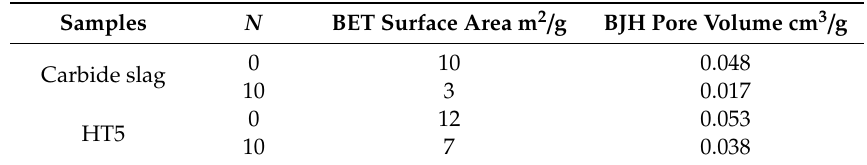
Table 4. Surface areas and pore volumes of HT5 and carbide slag (carbonation in 15% CO 2 / N 2 at 700 ◦ C for 20 min, calcination in 70% CO 2 / N 2 at 920 ◦ C for 10